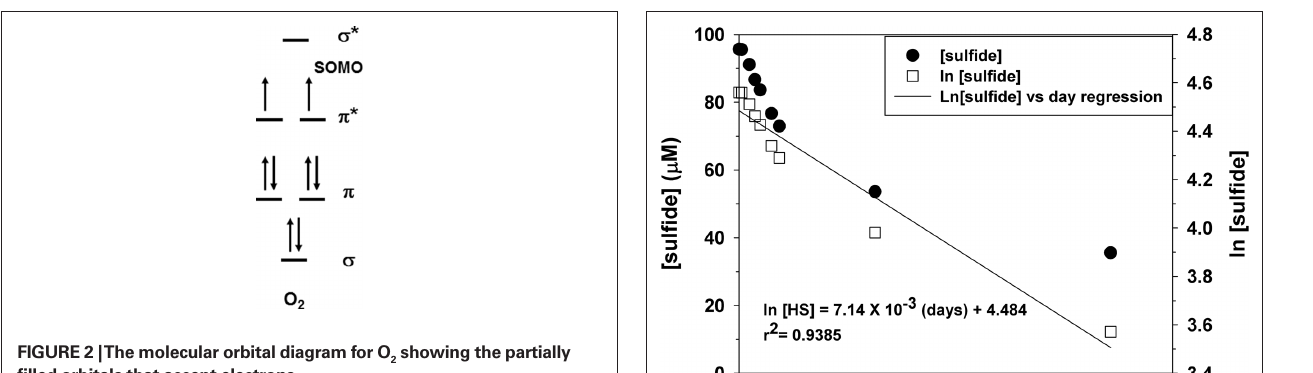
showing the partially 2